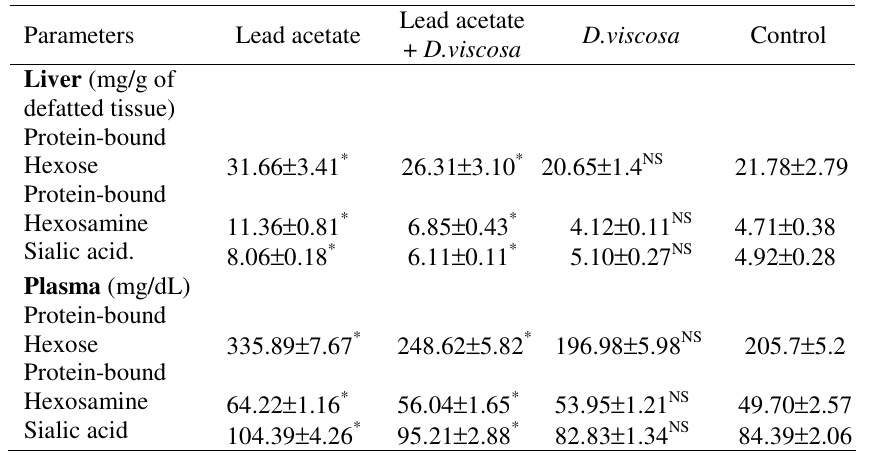
Table 1. Levels of protein-bound hexose, protein-bound hexosamine and sialic acid in experimental and control animals (mean ± SD;